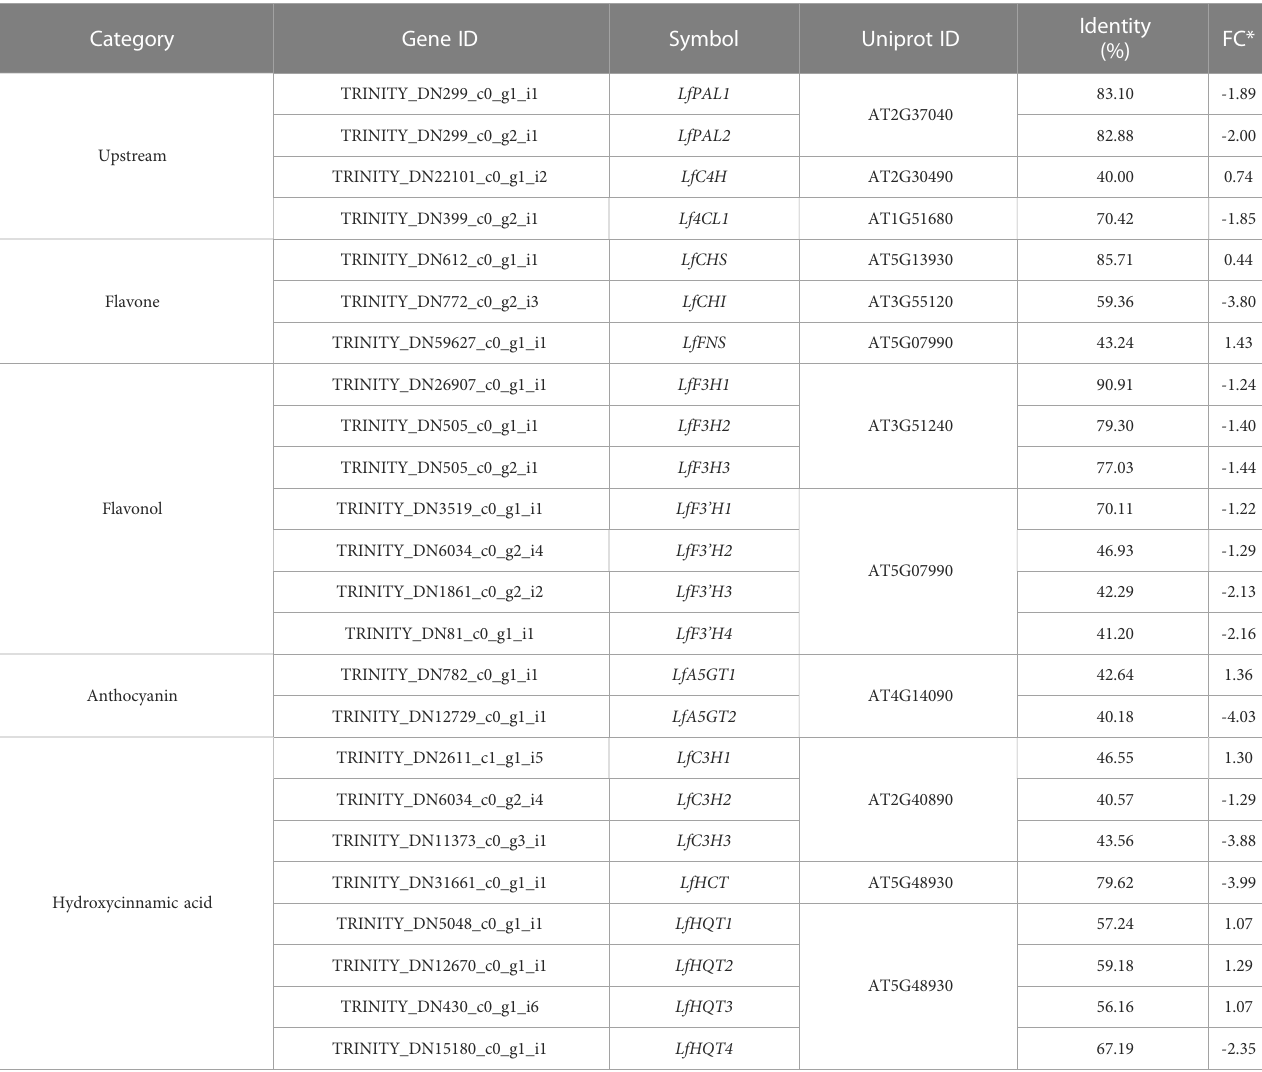
TABLE 4 List of genes related to phenylpropanoid biosynthesis in L. fi scheri.